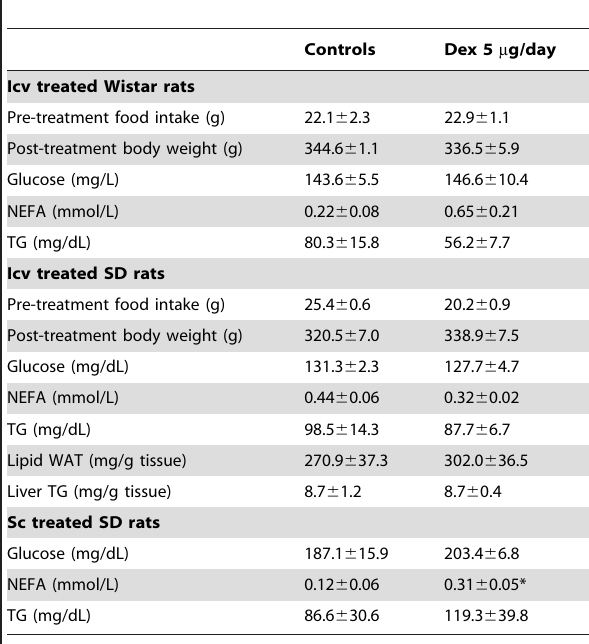
Table 1. Effects of dexamethasone treatment on metabolic